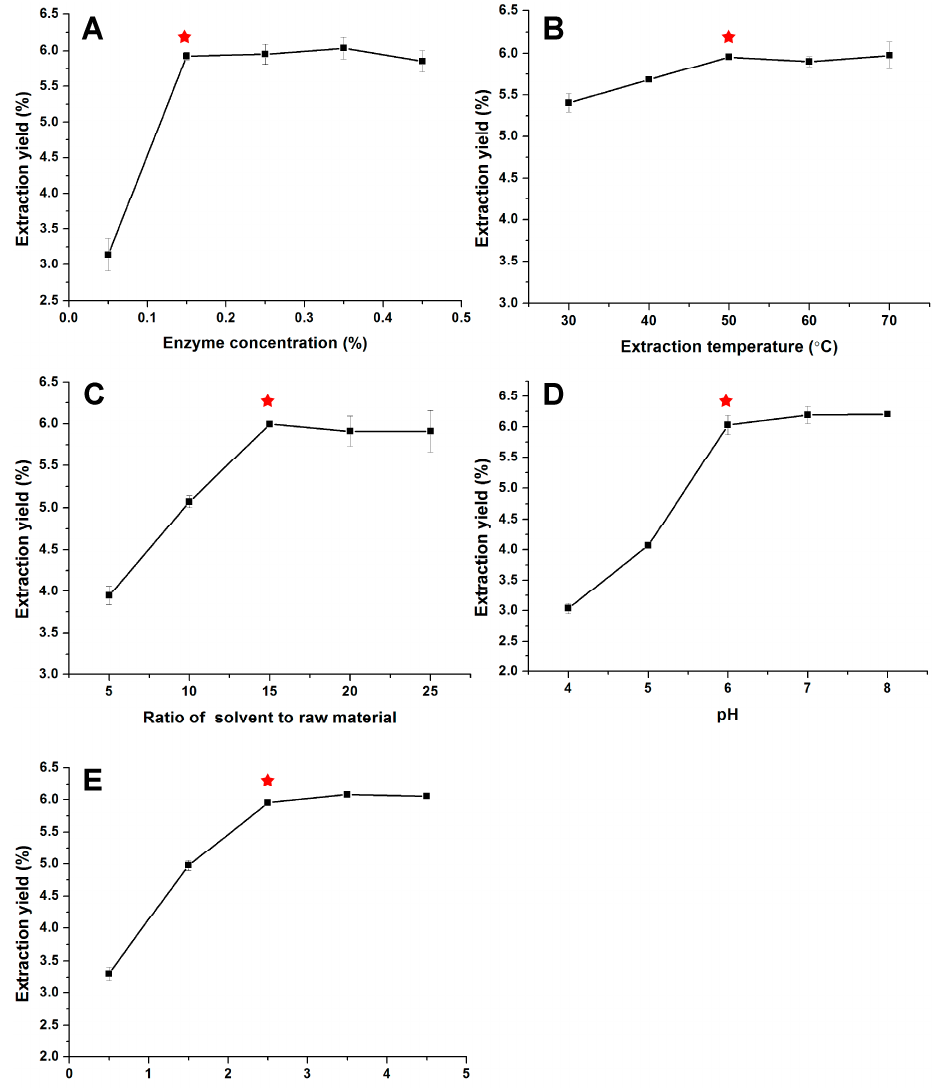
Figure 1. Effects of different extraction parameters such as enzyme concentration ( A ), temperature ( B ), ratio of solvent to raw material ( C ), pH ( D ), and time ( E ) on the yield of polysaccharides from sea cucumber Phyllophorus proteus . ★ indicates the optimal reaction condition for each single-factor test.